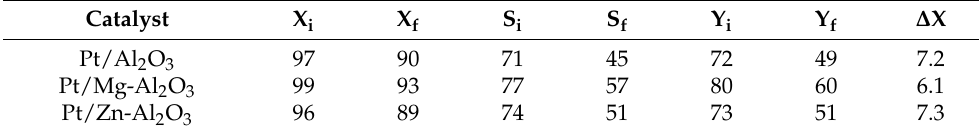
Table 1. Summary of catalysts’ performance for dehydrogenation of H18-DBT.